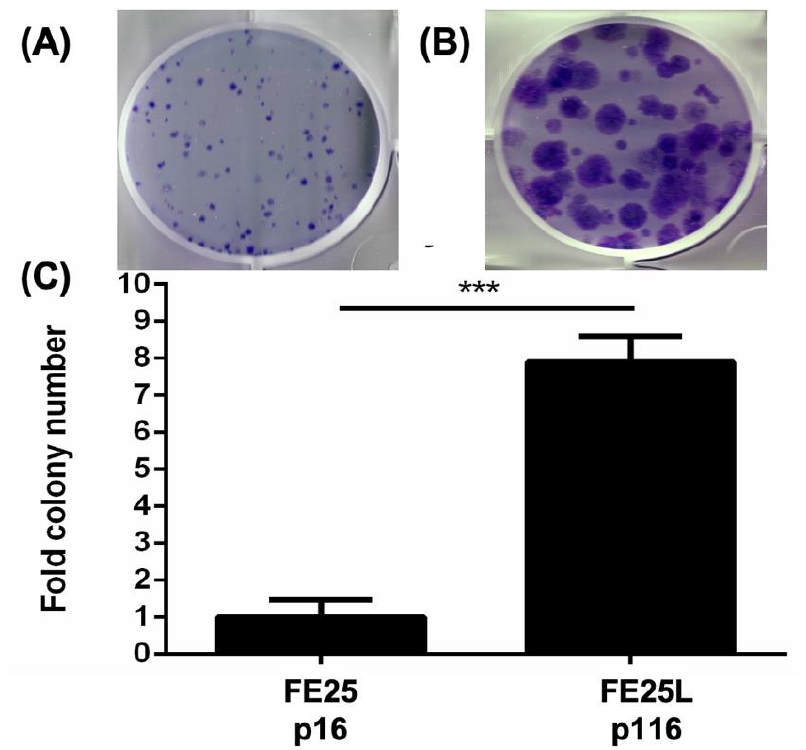
Figure 3. Colony formation assay for FE25 (p16) and FE25L (p116) cells. 200 cells were plated in 2 mL of culture medium in one well of a six-well plate. After 14 days, the colonies were stained with crystal violet and counted. ( A , B ) Representative colony growth of FE25 ( A ) and FE25L (B) cells. ( C ) Quantification of the colony numbers in three replicates. *** p < 0.001.